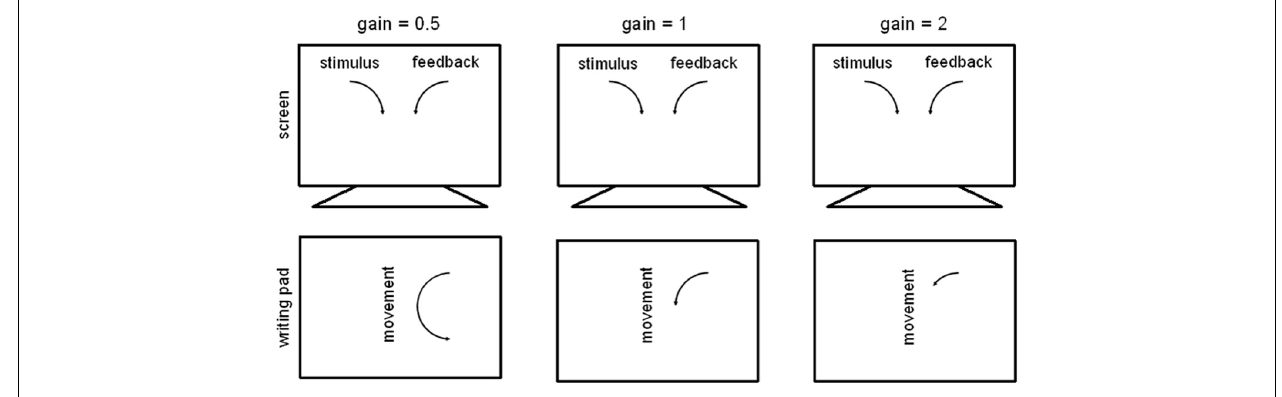
FIGURE 1 | Illustration of the gain manipulations. Altogether nine different gains were conducted in the experiment: 0.5, 0.6, 0.75, 0.8, 1, 1.25, 1.3, 1.5, and 2. Note that the depiction of stimulus, feedback and movement are not scaled to actual size on the screen and on the writing